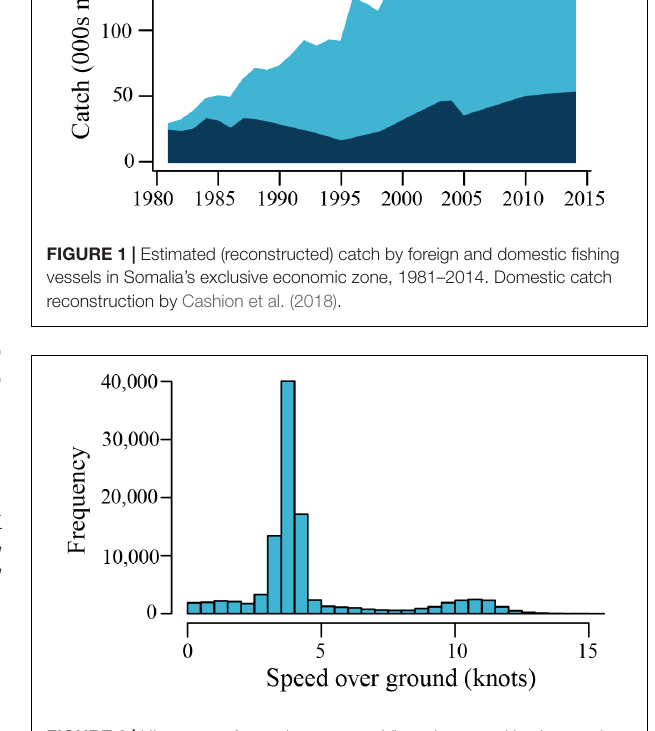
FIGURE 2 | Histogram of speed over ground (knots) reported by Automatic Identification System pings from seven South Korean-flagged trawlers